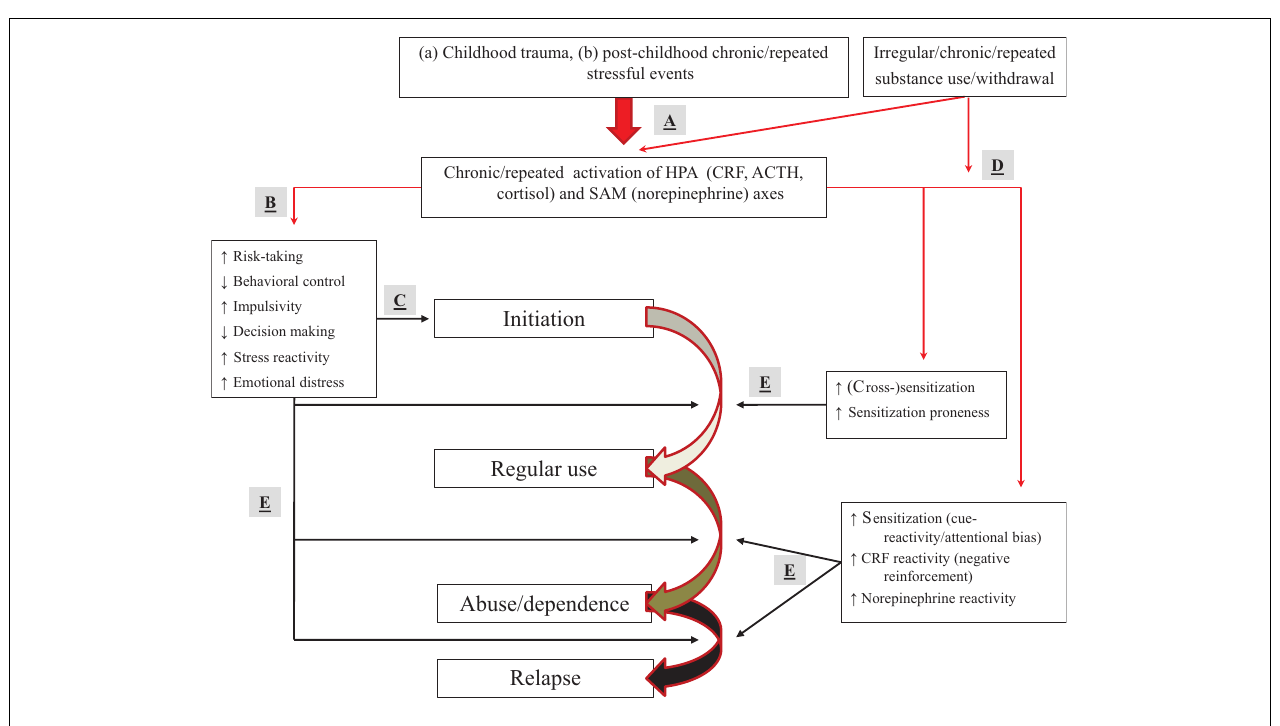
effects on trait-like factors can result in first-time use of a substance. (D) Stress and irregular, repeated, or chronic substance use can affect sensitization mechanisms. (E) Sensitization (in conjunction with stress effects on trait-like factors) can result in escalation to regular use, abuse/dependence, and lapse/relapse. People with trait-like high risk-taking, impaired decision making, poor behavioral control or high impulsivity, increased stress reactivity, or elevated emotional distress with a belief that substances diminish negative affect, are at particular